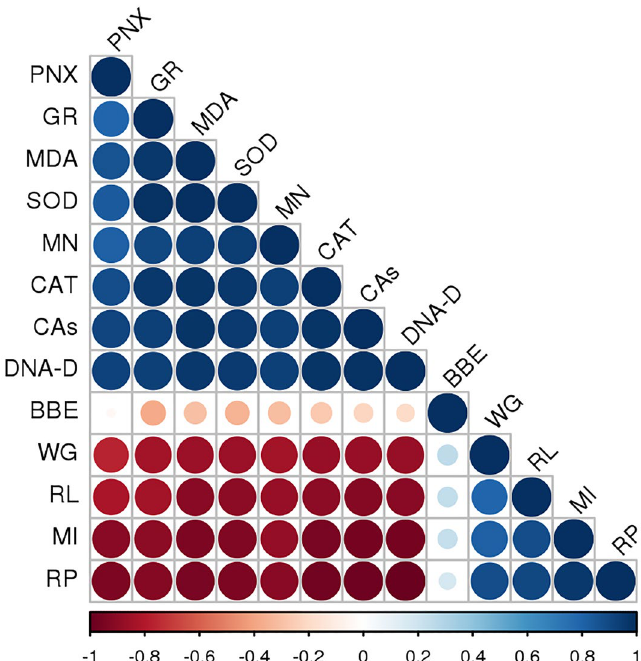
Figure 9. Correlations of penoxsulam and BBE doses with cytological, morphologic and biochemical analysis ( PXM penoxsulam dose, GR glutathione reductase activity, MDA malondialdehyde level, SOD superoxide dismutase activity, MN micronucleus formation, CAT catalase activity, CAs chromosomal abnormality frequency, DNA-D DNA damage (arbitrary unit), BBE blue berry extract, WG weight gain, RL root length, MI mitotic index, RP rooting